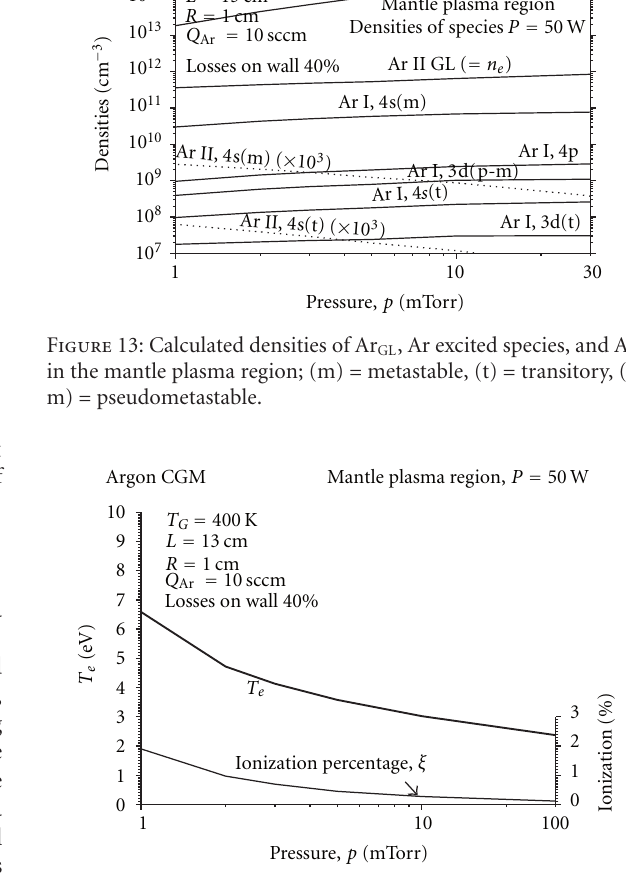
Figure 14: Calculated T e and ionization percentage in the mantle plasma